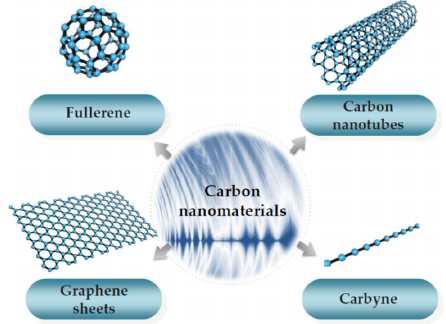
Figure 1. Kinds of carbon